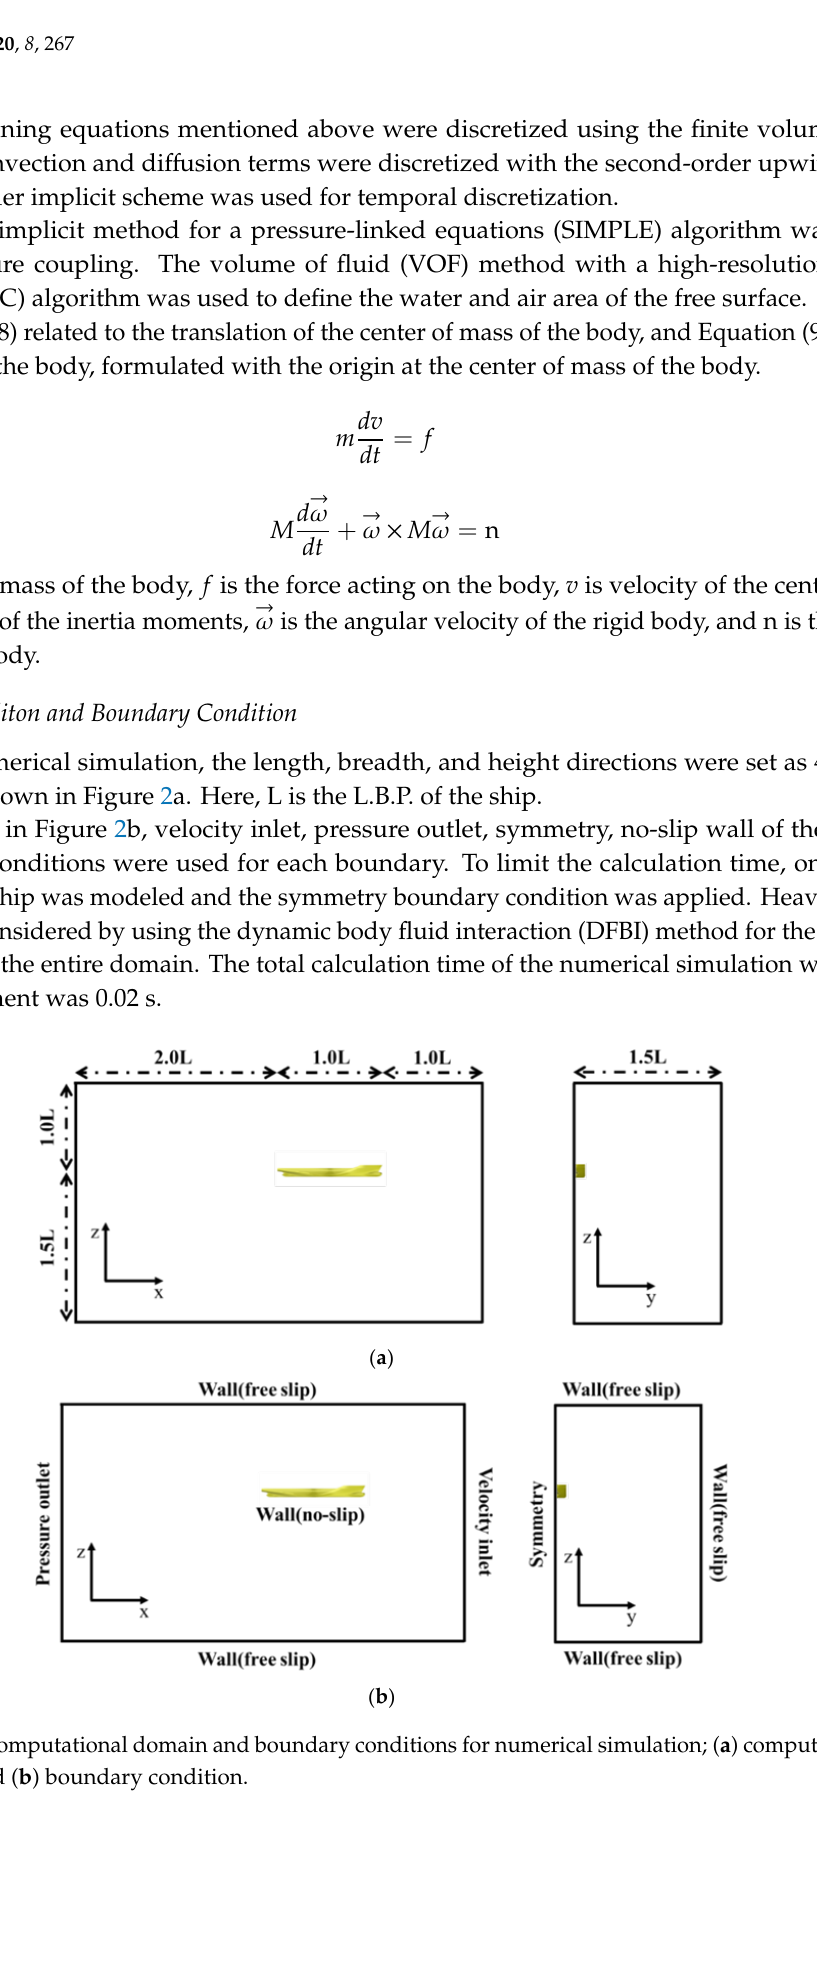
Table 2. Principal dimensions of KCS (center of gravity means (from A.P. to F.P., centerline, from baseline to upward)).